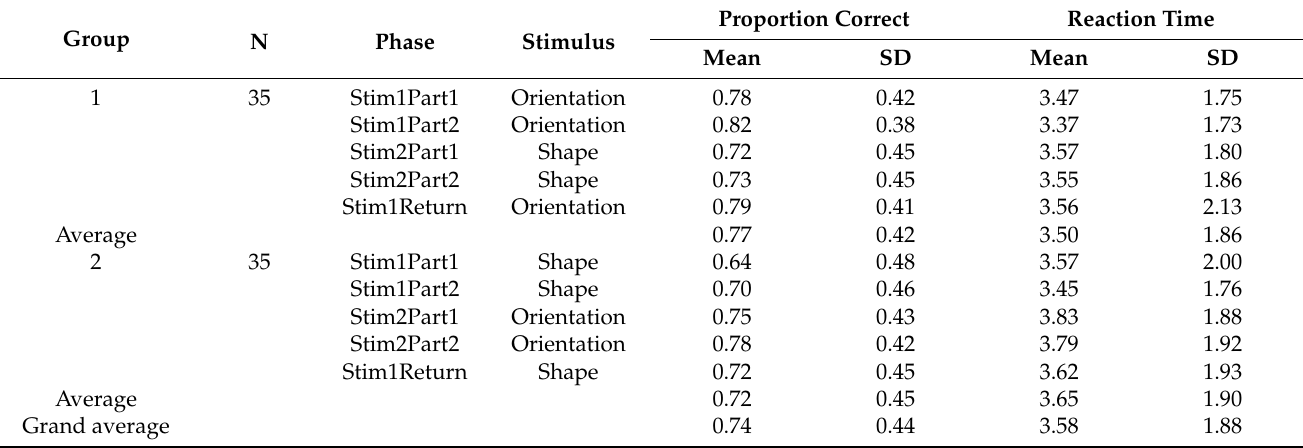
Table 1. The descriptive statistics of the proportion correct and reaction time for each phase.